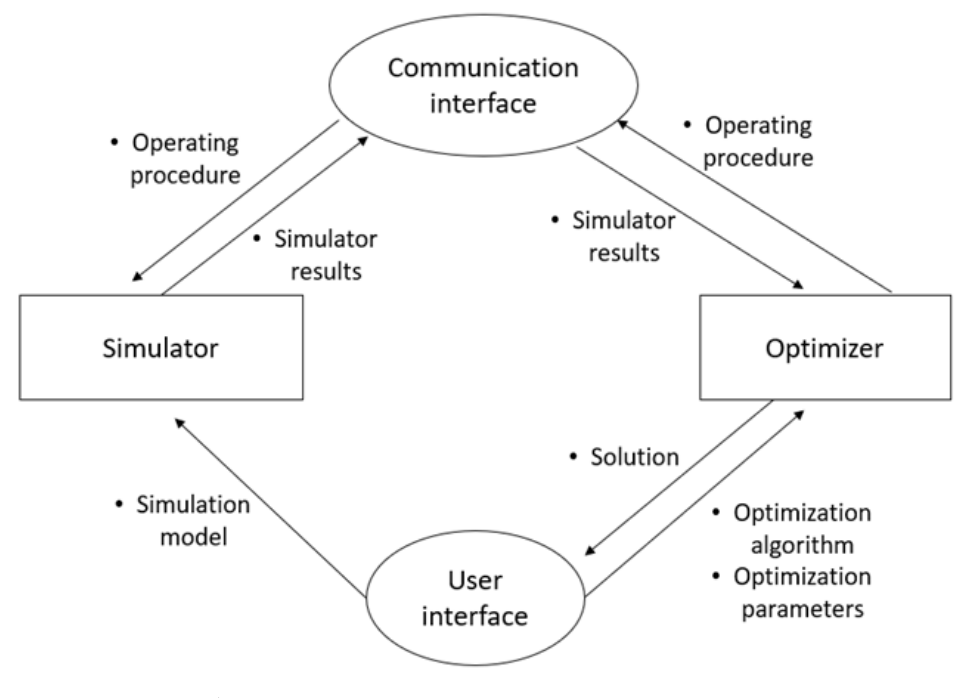
Figure 3. System architecture.